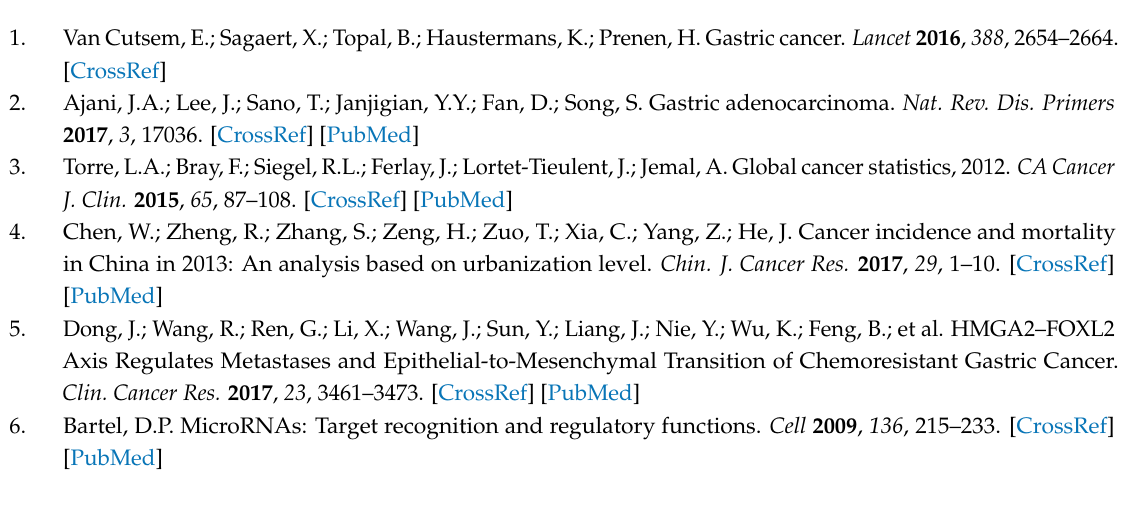
Figure S1: The strategy of integrative analysis of dysregulated lncRNA-associated ceRNA network in GC, Figure S2: PCC distribution in GC. (A) PCC higher the 95 percentile of the overall correlation distribution of lncRNA-mRNA pairs in GC. (B) PCC lower the 95 percentile of the overall correlation distribution of mRNA–miRNA pairs in GC. (C) PCC higher the 95 percentile of the overall correlation distribution of lncRNA–miRNA pairs in GC, Table S1: Differentially expressed lncRNAs, mRNAs, and miRNAs, Table S2: Potential ceRNA triples in GC-related ceRNA networks, Table S3: Functional enrichment analysis of ceRNA network. Table S4: The BC of all nodes in the ceRNA